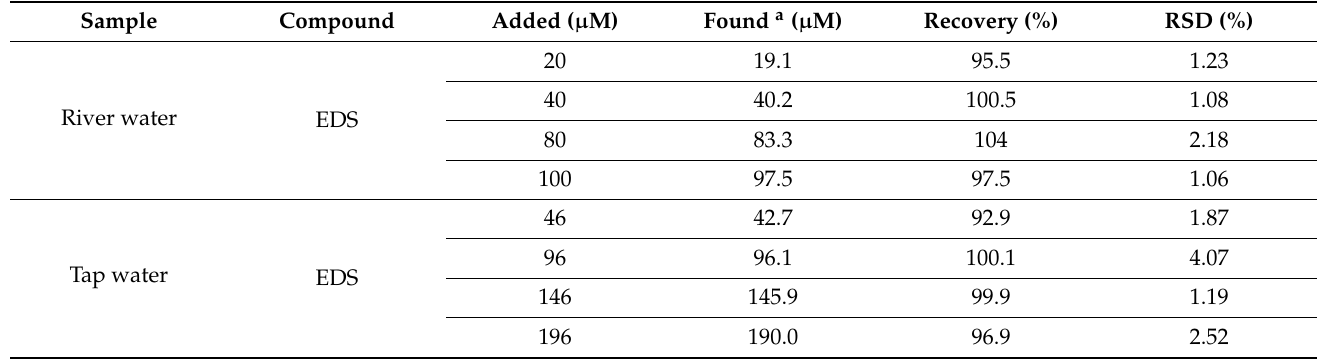
Table 2. Determination of the concentration of EDS in river water and tap-water samples by SWV. ( a Average value of three